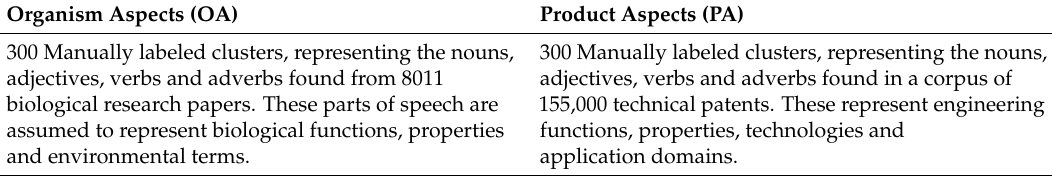
Table 3. The Scalable Search for systematic Biologically Inspired Design (SEABIRD) system and Product Aspects in Design by Analogy (PAnDA) tool cluster sub-models are used as indices when searching a repository of processed and annotated biological research papers. They are independently extracted from biology research papers and linked. Adapted from Verhaegen and colleagues [67,68] and Vandevenne et al.